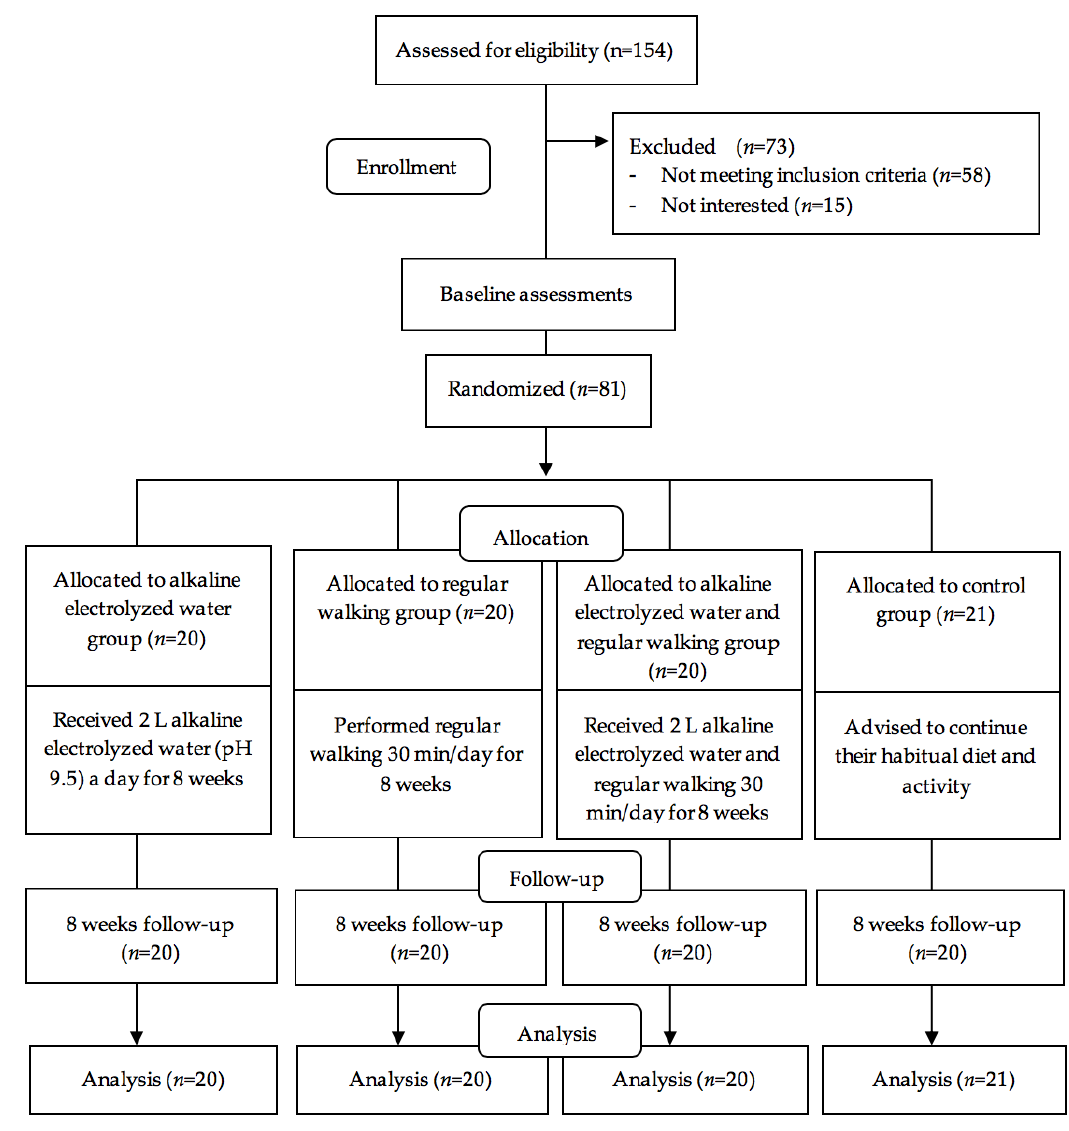
Figure 1. CONSORT diagram of this Study.